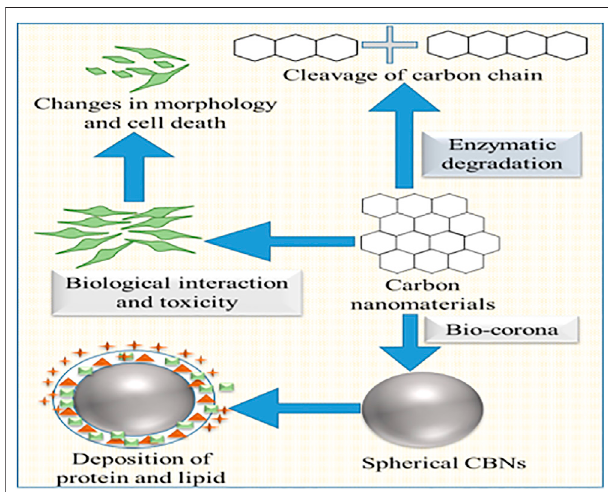
FIGURE 3 | Changes in physicochemical properties due to